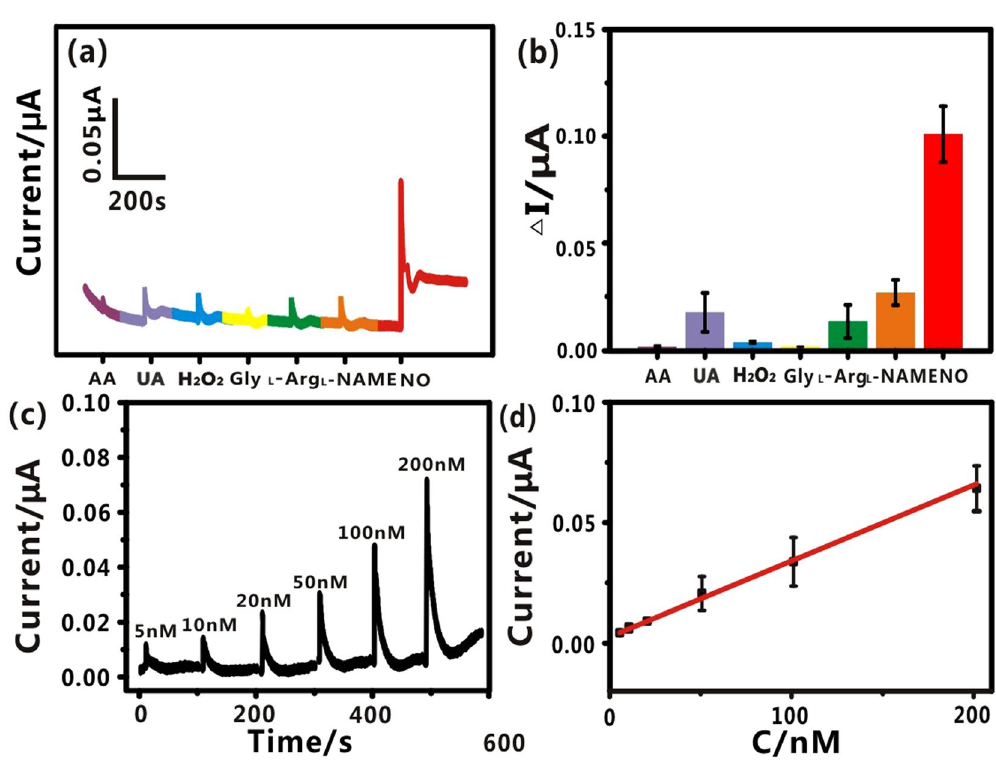
Figure 3. ( a ) Amperometric response of the FGPC/AN to interference substances in deaerated PBS solutions, in which all species were at the concentration of 1 mM. ( b ) Histogram of selective profile. ( c ) Amperometric response of FGPC/AN to the increased concentrations of NO in deaerated PBS solution at potential of + 0.78 V (vs. Ag/AgCl). ( d ) The calibration curve of FGPC/AN to a series of NO concentrations. Ip( μ A) = 0.0003C NO (nM) + 0.0027, R 2 = 0.9967. Error bars represent standard deviations of measurements (n =